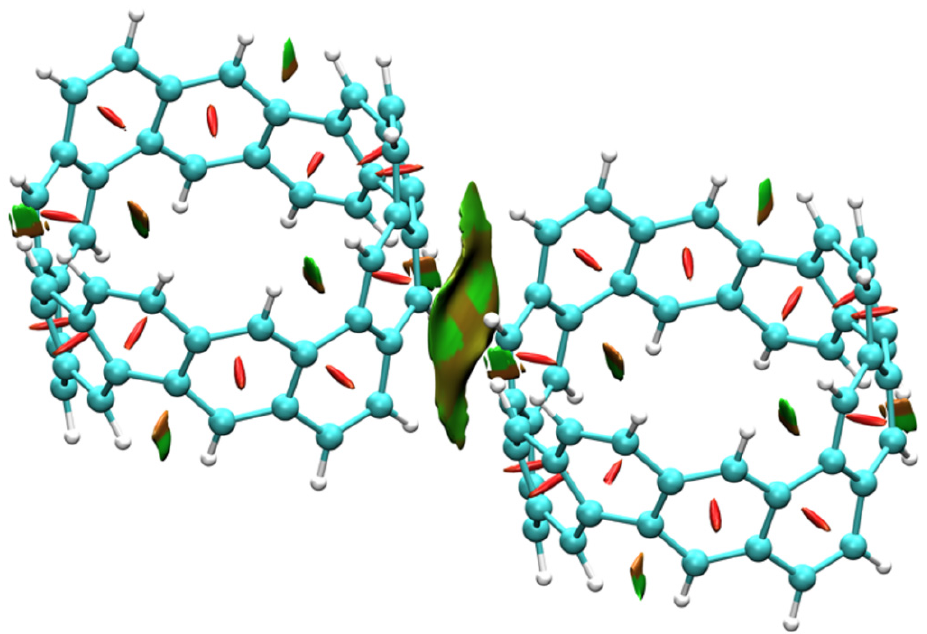
Figure 8. The optimized structure and RDG diagram (isovalue = 0.5) of [6, 6]CNB dimer. The adsorption surface corresponds to the value surface of the sign ( λ 2 ) ρ function mapped to the interaction, in a.u.